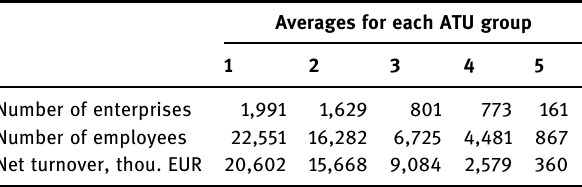
Table 4: Administrative territorial units broken down by level of economic development ( quantitative assessment ) Averages for each ATU